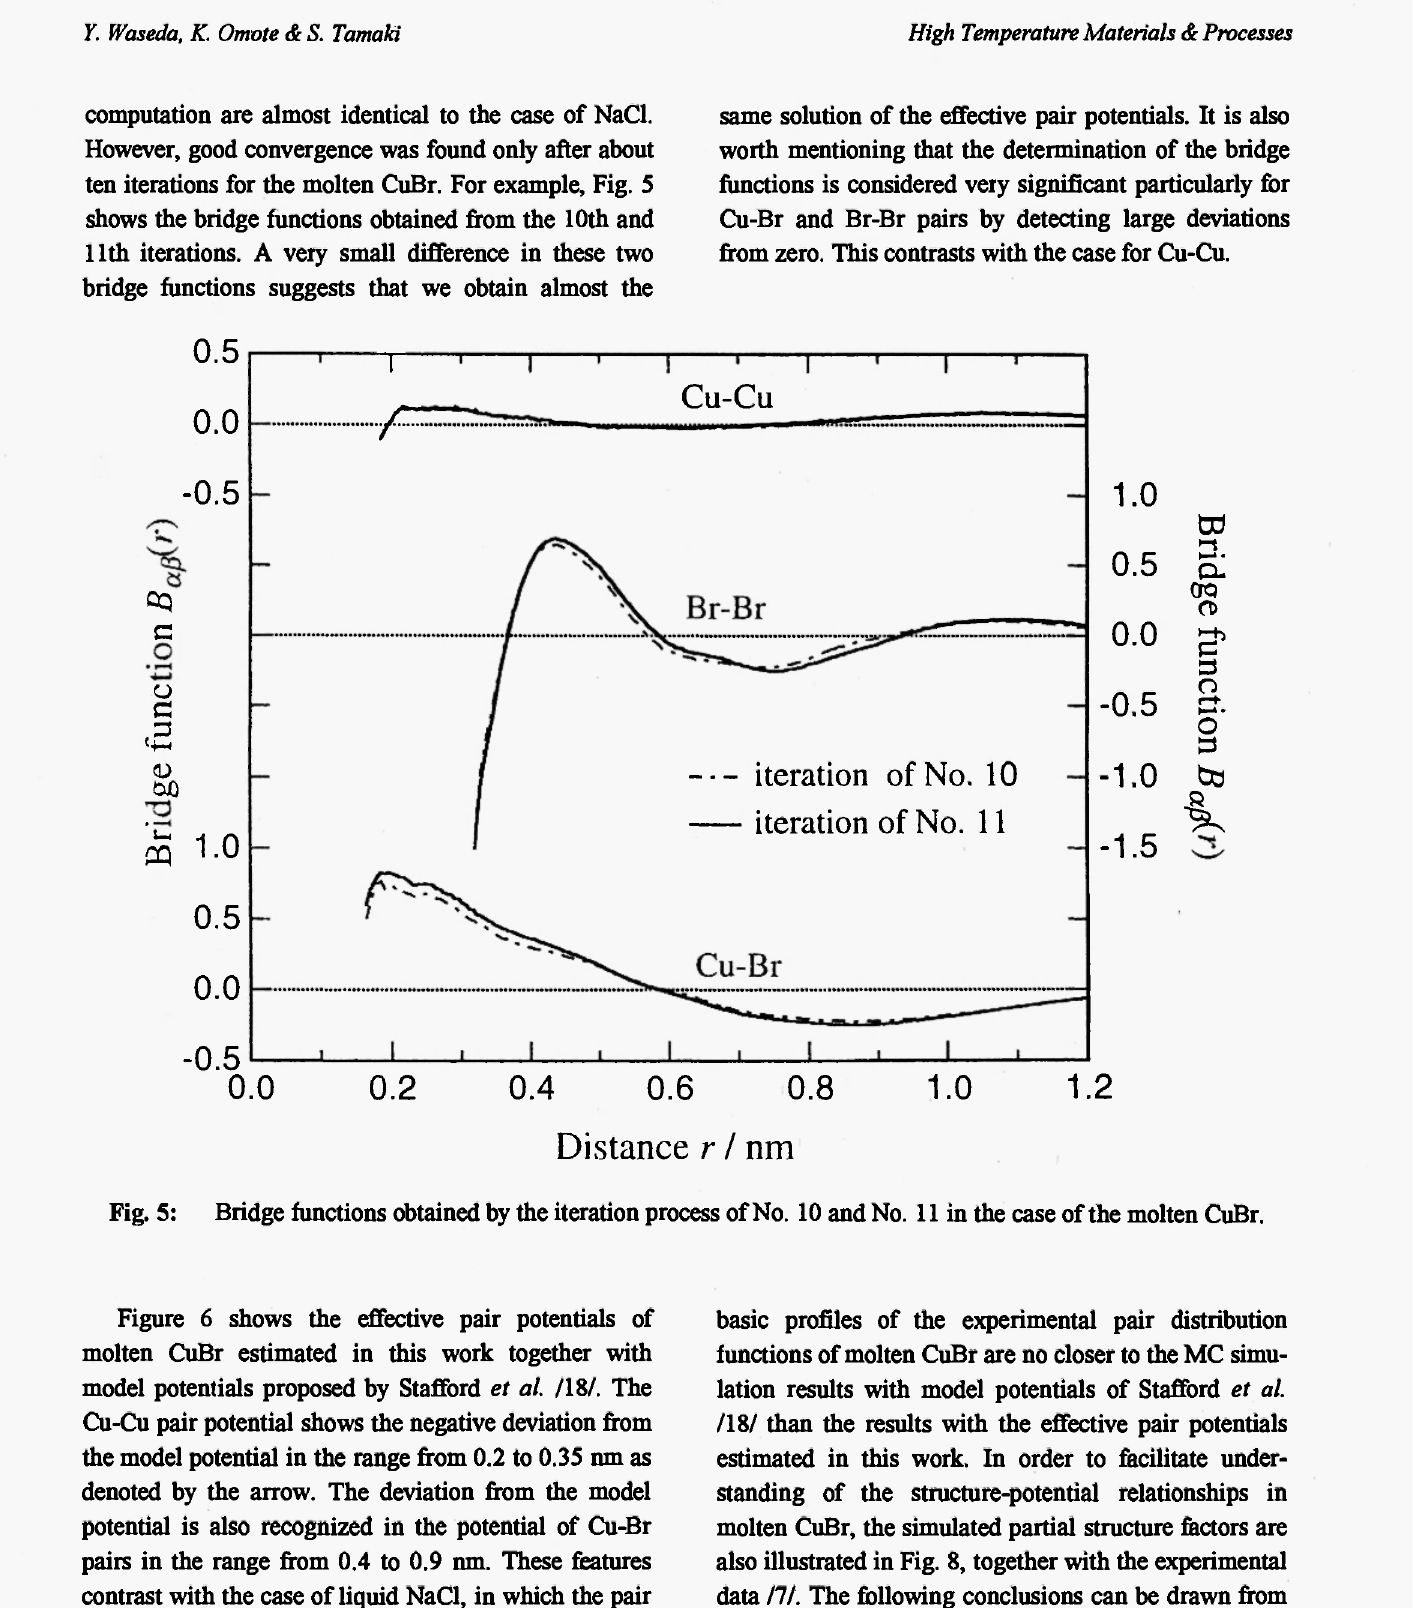
basic profiles of the experimental pair distribution functions of molten CuBr are no closer to the MC simu- lation results with model potentials of Stafford et al. /18/ than the results with the effective pair potentials estimated in this work. In order to facilitate under- standing of the structure-potential relationships in molten CuBr, the simulated partial structure factors are also illustrated in Fig. 8, together with the experimental data 111. The following conclusions can be drawn from these